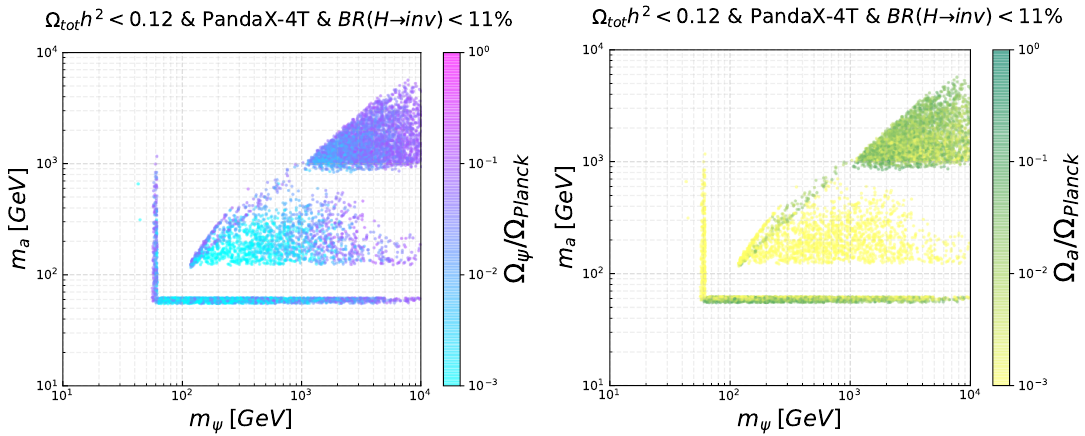
Figure 12. The distribution of relic density among species in the mass plane. Note that points with relic density below 10 − 3 Ω are shown with colour corresponding to the smallest PLANCK